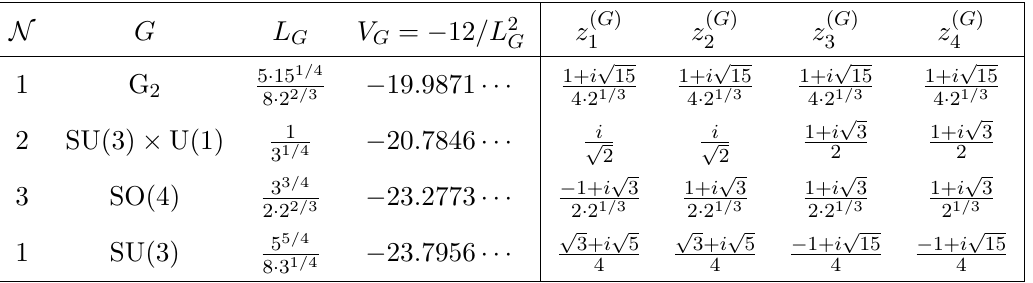
Table 1 . Supersymmetric AdS 4 solutions ordered by decreasing value of the scalar potential V G . The (cid:12)rst four columns show respectively the number of preserved supersymmetries in the maximal theory, the residual gauge symmetry preserved at the AdS 4 solution, the value of the AdS 4 radius, and a numeric approximation to the value of V G . The last four columns give the position of the AdS 4 solutions in (cid:12)eld space. We have set g = m =